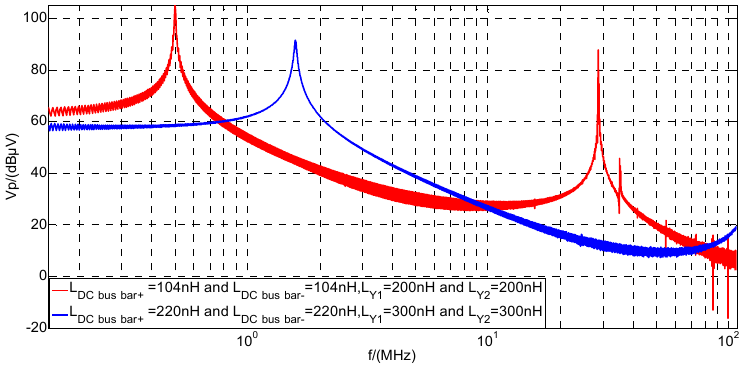
Figure 15. Positive CE voltage after L DC bus bar+ , L DC bus bar − , L Y1 and L Y2 were increased.